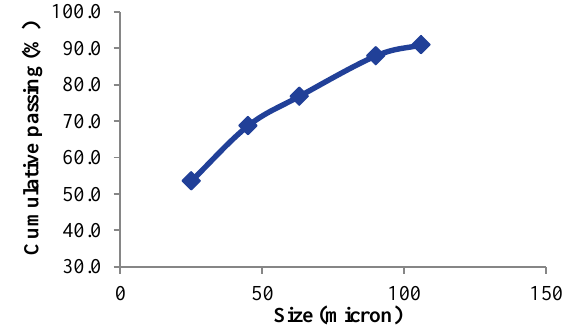
Figure 3. Influence of the flocculant A26